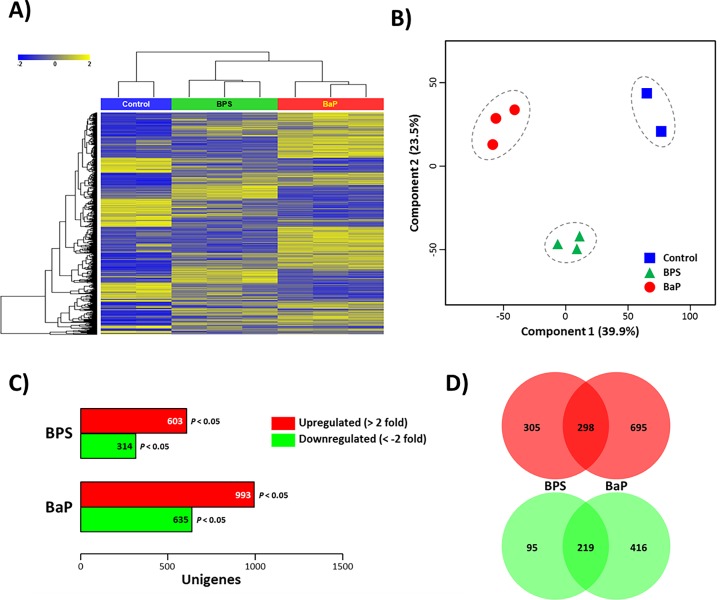
Comparison of transcriptional expression patterns of whole libraries and analysis of chemical-specifically expressed genes.(A) Transcriptional pattern analysis of each library (i.e., two control, three BPS-exposed, and three BaP-exposed liver tissues) by employing heat map and hierarchical clustering; (B) PCA plot analysis of transcriptional profile of each library. Each sample is depicted with a different color. (C) Number of statistically significant transcripts (i.e., over 2 fold; P < 0.05) in P. olivaceus liver tissues exposed to BPS or BaP; (D) the number of uniquely or commonly up- or downregulated transcripts in the P. olivaceus liver tissues exposed to BPS or BaP. Detailed list of the commonly modulated genes is included in S5 and S6 Tables.